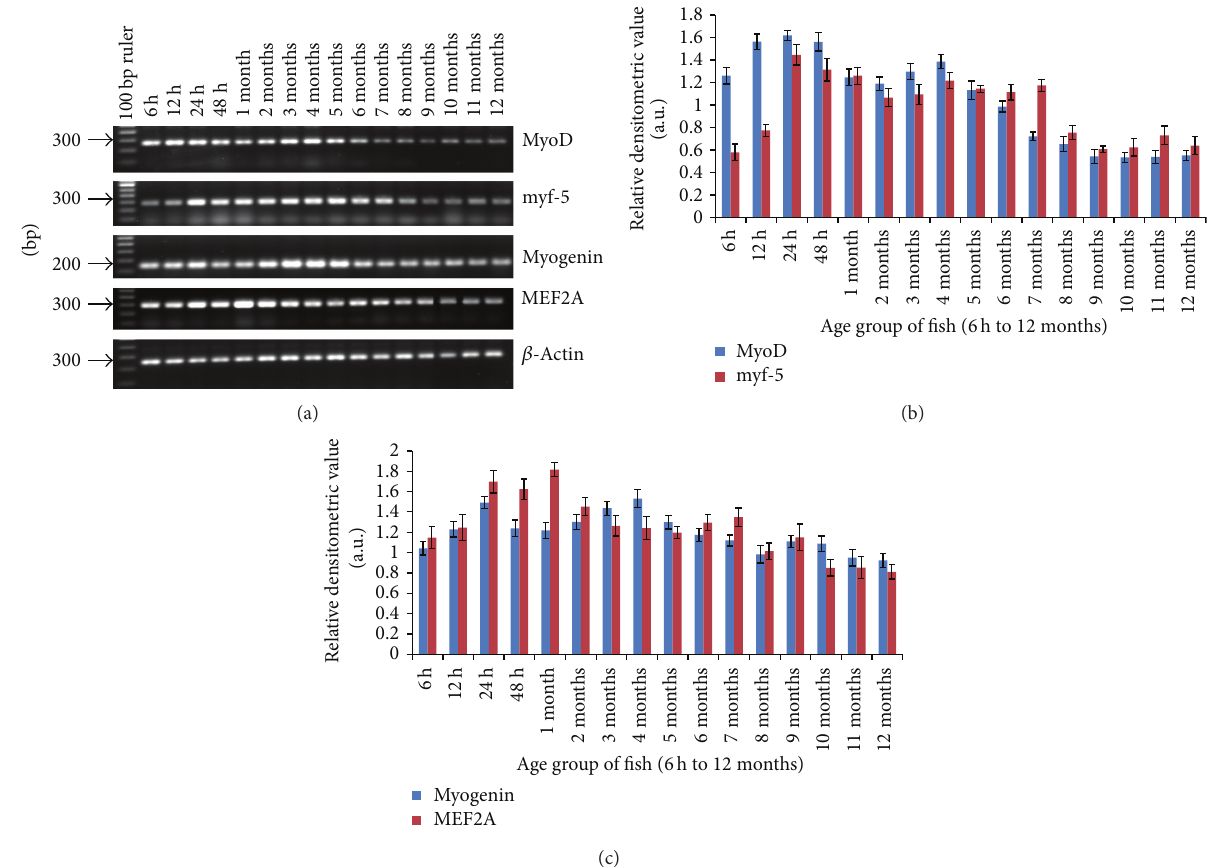
Figure 2: mRNA transcription pattern of myogenic regulatory factors by RT-PCR (a) expression of MyoD, myf-5, myogenin,and MEF2A mRNA at different time points of growth (6 hours to 12 months), (b) relative densitometric analysis of MyoD and myf-5 expression, and (c) relative densitometric analysis of myogenin and MEF2A expression. Values are expressed as mean ± SEM ( 𝑁 = 6